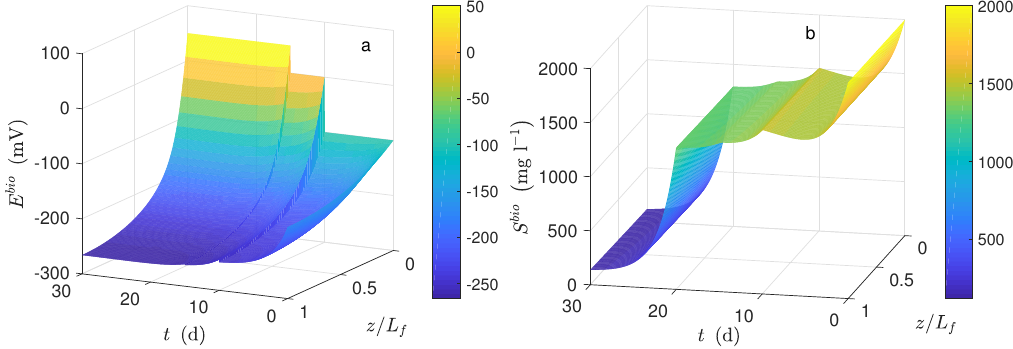
Figure 1. Numerical solution for the Microbial Electrolysis Cells (MEC) model during chronoamperometry operation. ( a ) Potential distribution in the biofilm and ( b ) substrate distribution in the biofilm.